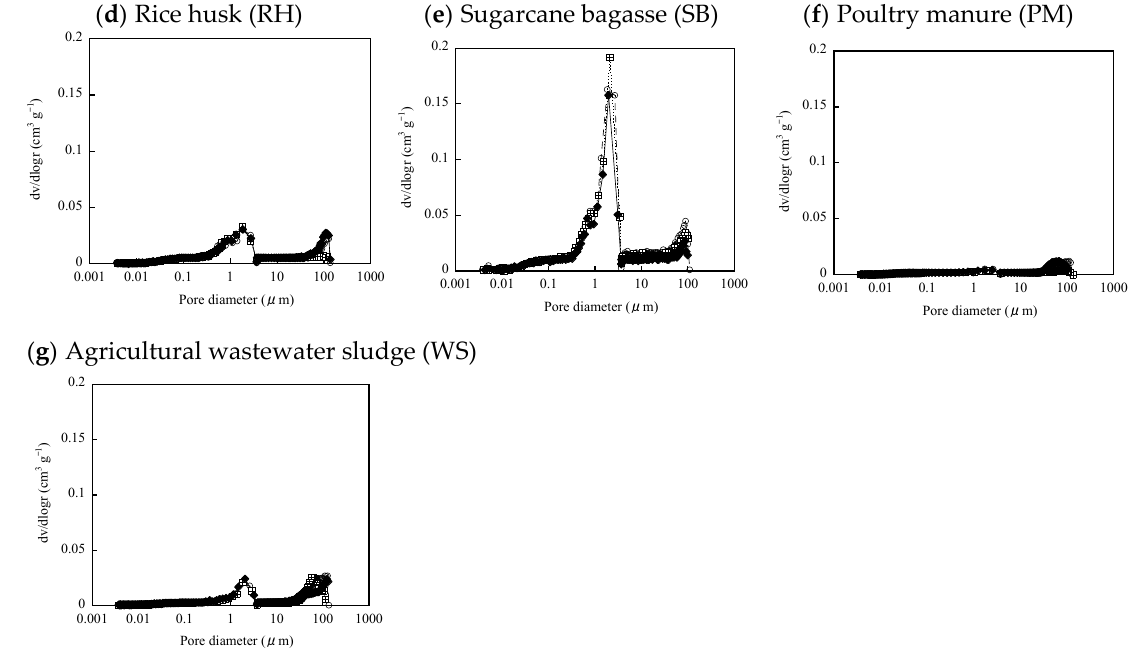
Figure 3. Pore size distribution (PSD) of biochar samples, measured by mercury-intrusion porosimetry (MIP). ( a ) Japanese cedar (CE); ( b ) Japanese cypress (CY); ( c ) moso bamboo (MB); ( d ) rice husk (RH); ( e ) sugarcane bagasse (SB); ( f ) poultry manure (PM); ( g ) agricultural wastewater sludge (WS). Table 2. Volumes of different pore size and pores corresponding to available water capacity (AWC) of biochar samples, estimated from pore-size distribution (PSD) measured by mercury-intrusion porosimetry (MIP) method .